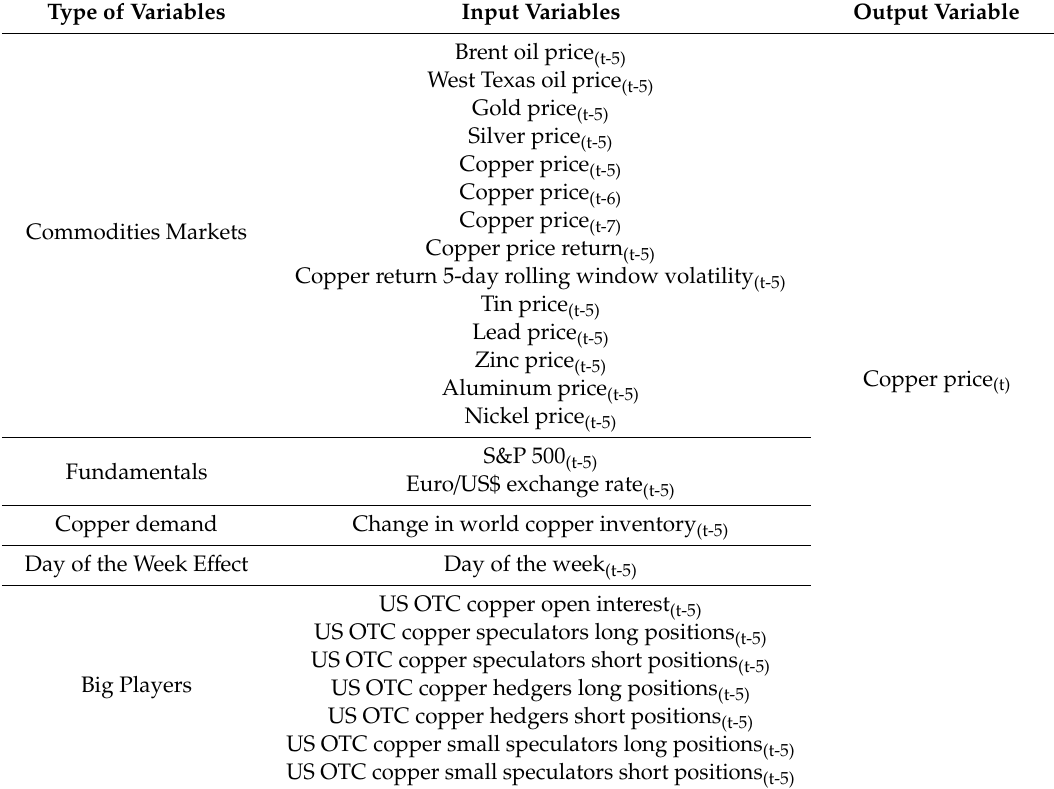
Table 1. Modelling framework. Input variables, and output